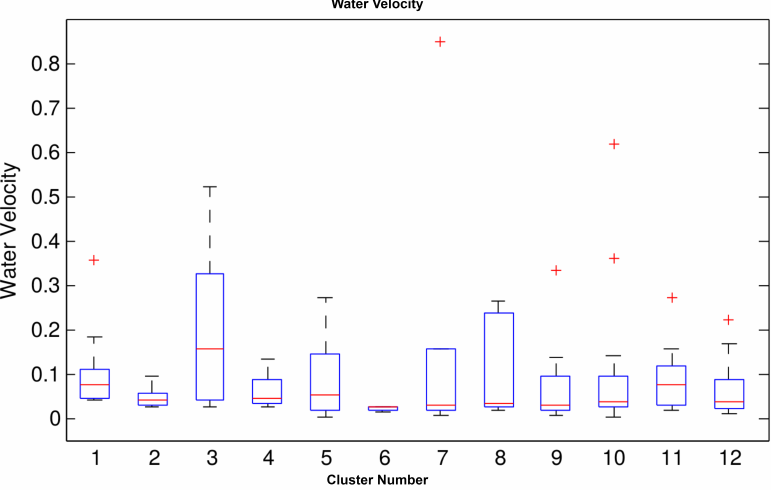
Figure 8. The water velocity data divided in K = 12